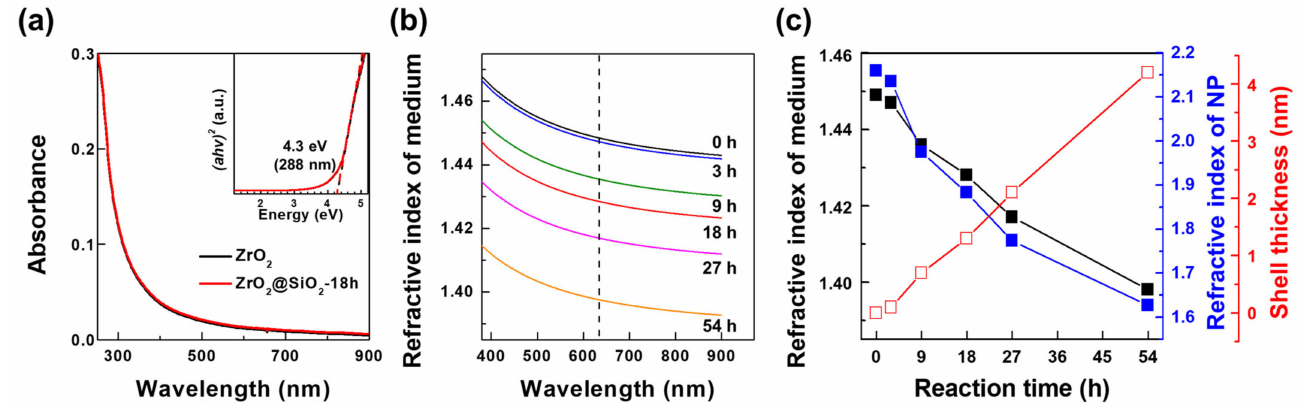
Figure 4. ( a ) UV-vis absorption spectra of (black) ZrO 2 and (red) ZrO 2 @SiO 2 -18h NPs. The inset shows the corresponding Tauc plots for (black) ZrO 2 and (red) ZrO 2 @SiO 2 -18h NPs. ( b ) Refractive index dispersions of aqueous solutions of ZrO 2 @SiO 2 NPs prepared with different reaction times. All solutions were prepared with 50 wt% NP content. ( c ) Refractive (black) indices (at λ = 633 nm) for ZrO 2 @SiO 2 NP solutions with different reaction times and (red) calculated SiO 2 layer thicknesses, as well the (blue) effective refractive indices of ZrO 2 @SiO 2